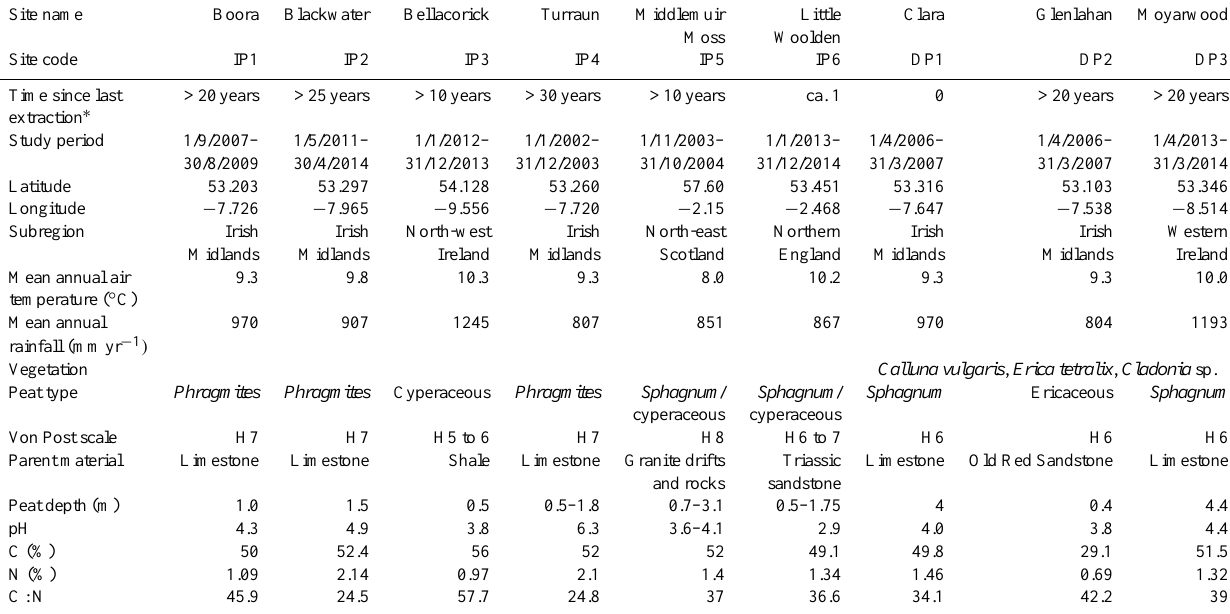
Table 1. Site characteristics. Mean annual air temperature ( ◦ C) and mean annual rainfall (mmyr − 1 ) are long-term values (1981–2010; Met Éireann, http://www.met.ie/, and Met Office UK,